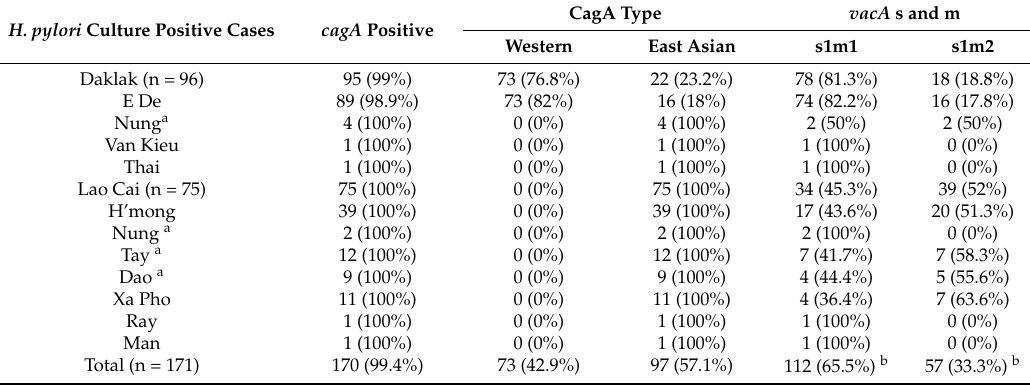
Table 4. The distribution of cagA and vacA among minor ethnic group in Daklak and Lao Cai province. H. pylori Culture Positive Cases